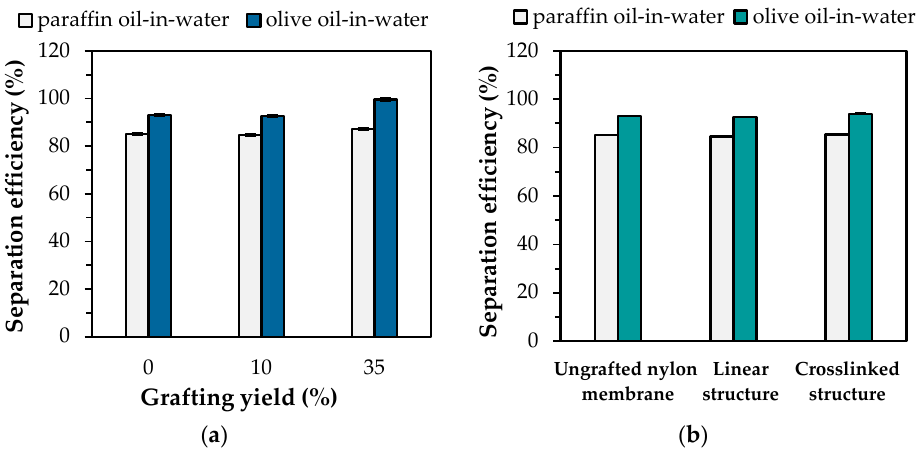
Figure 10. The separation efficiencies of O/W emulsions at 25 °C of : ( a ) linear PNIPAm - grafted nylon membrane with different grafting yields; ( b ) PNIPAm - grafted nylon membrane with different ar- chitectures .